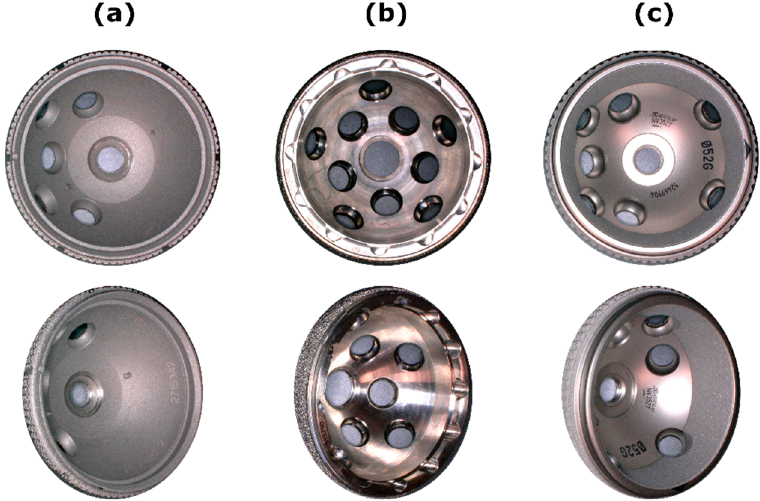
Figure1. Acetabulartitaniumhipcupcomponents. ( a )ZimmerBiomet, ( b )DePuySynthes, ( c Figure 1. Acetabular titanium hip cup components . ( a ) Zimmer Biomet, ( b ) DePuy Synthes, ( c ) Aesculap.